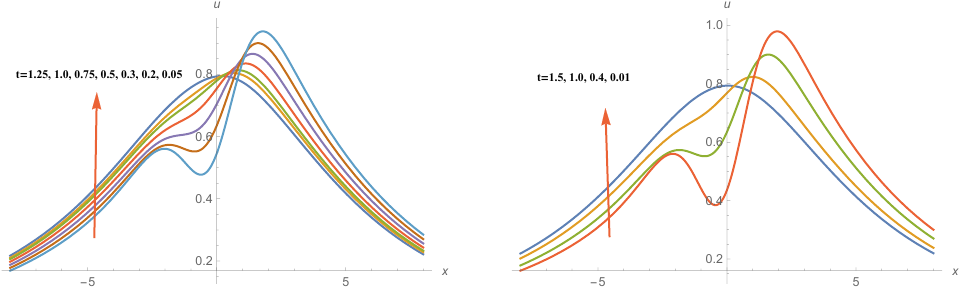
Figure 4. The solution of Equation (1) using ADM when p = 3 for different values of t . Example 3. In this last example, we examined the evolution of an initial Maxwellian pulse into solitary waves, arising as the initial condition of the